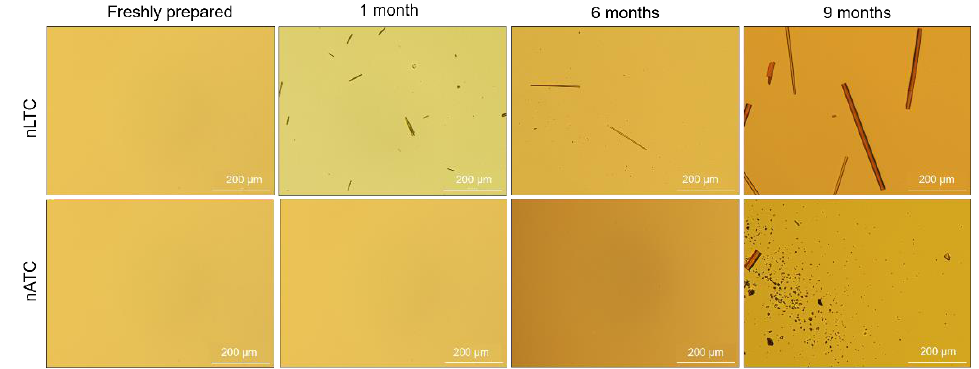
Figure 5. Clear field microscopy representative images showing freshly prepared and after stored at 4 °C CUR